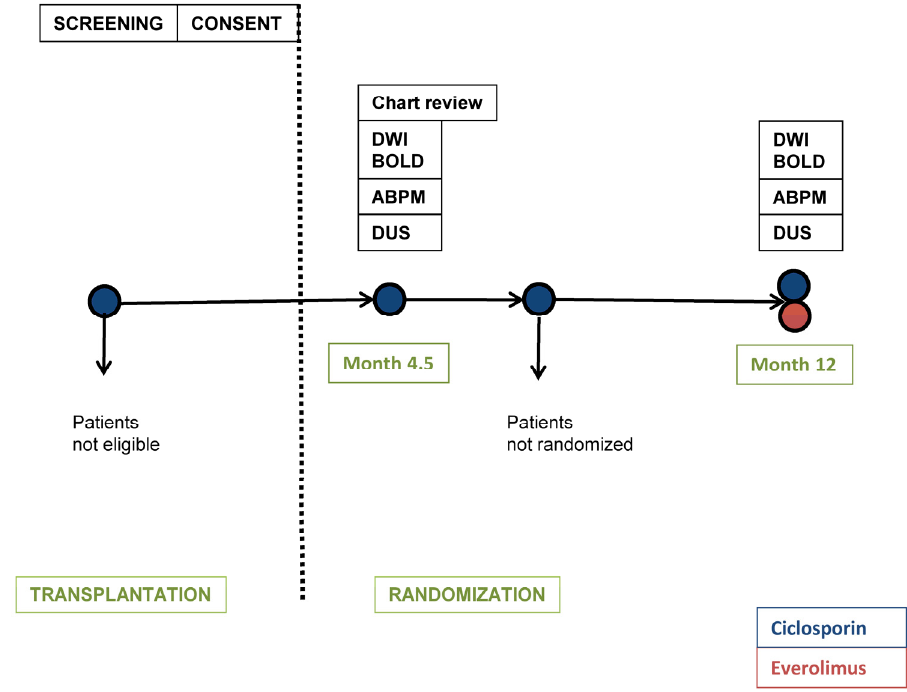
Figure 1. Study design. Diffusion-weighted imaging (DWI); blood oxygen level dependent-magnetic resonance imaging (BOLD-MRI); ambulatory blood pressure measurement (ABPM); duplex ultrasound scan (DUS).